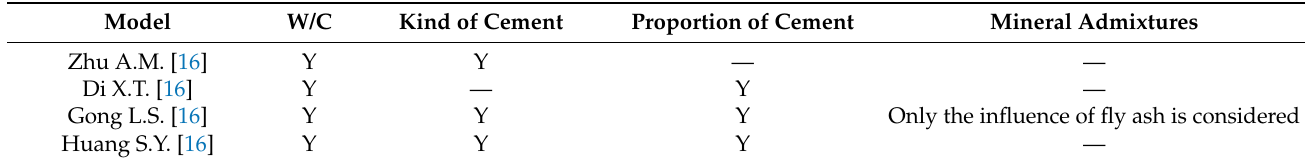
Table 2. Mostly considered factors in the existing